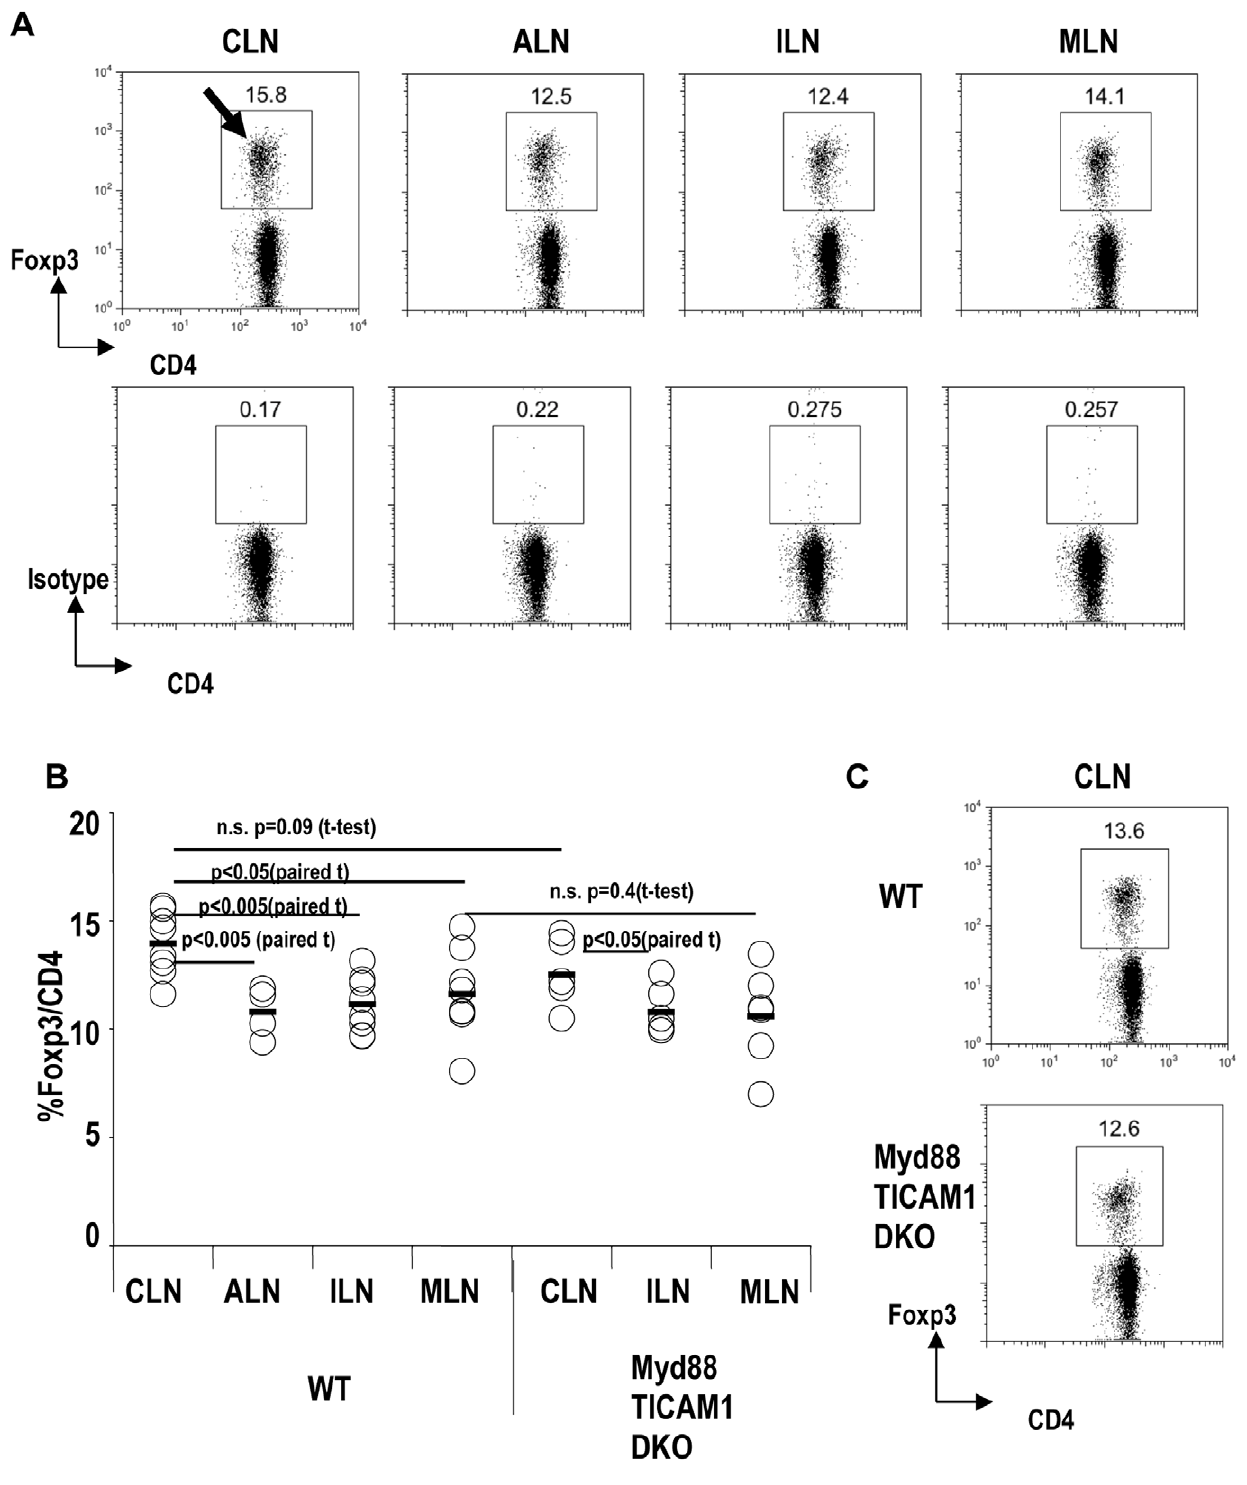
Figure 1. Frequency of Foxp3 + T-regs in cervical lymph node is increased in a Myd88/TICAM-1 independent manner. (A) Cervical lymph nodes (CLN), axillary lymph nodes (ALN), inguinal lymph nodes (ILN), and mesenteric lymph nodes (MLN) from wild type B6 mice were analyzed for the expression of Foxp3. The isotype control is shown at the bottom. Plots were gated on CD4 + T cells. Representative of seven separate experiments. (B) As in (A), but CLN, ALN, ILN and MLN from wild-type B6 mice (WT) or Myd88/TICAM1 double knockout mice (Myd88/TICAM1 DKO) were analyzed for the expression of Foxp3. Summary from seven separate experiments. P value provided is by paired t-test or t-test. ‘‘n.s.’’=‘‘not significant’’. (C) As in (B), but a representative of CLN is shown.